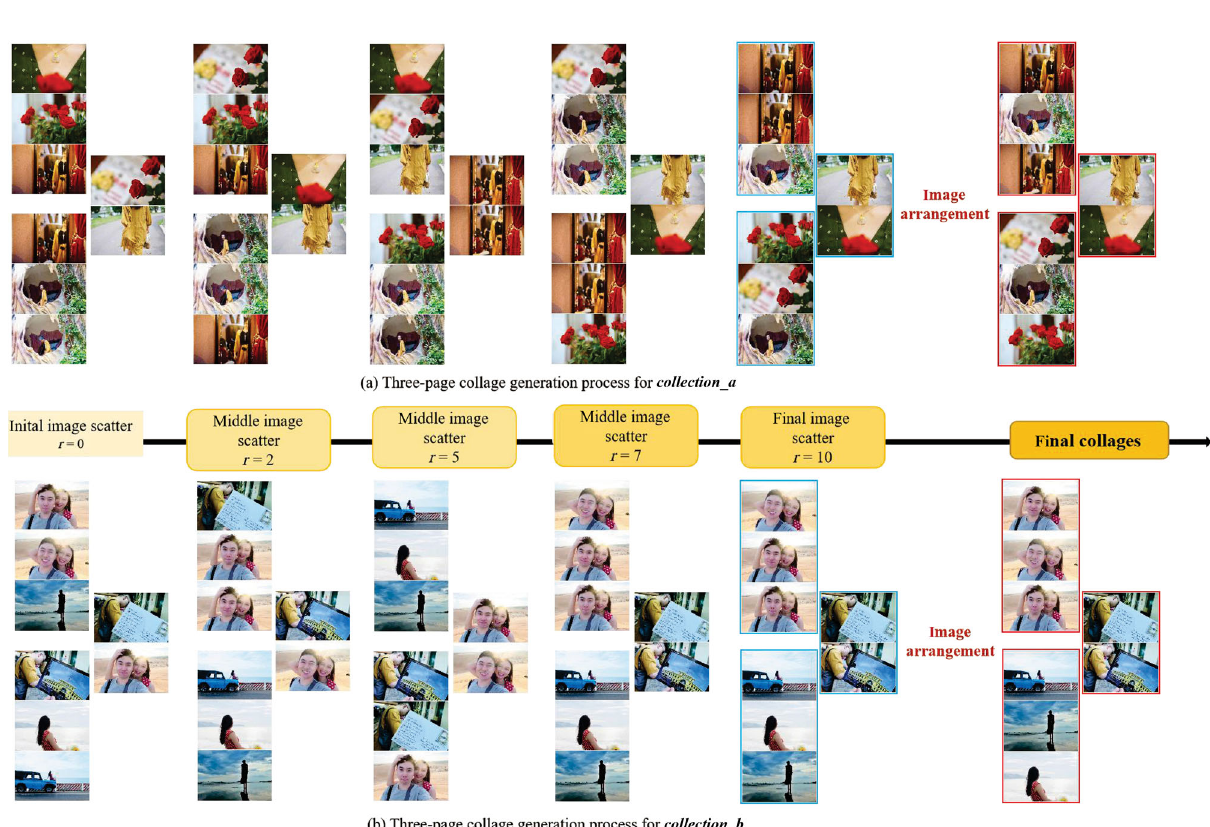
Fig. 8 Pipeline of three-page collage generation.